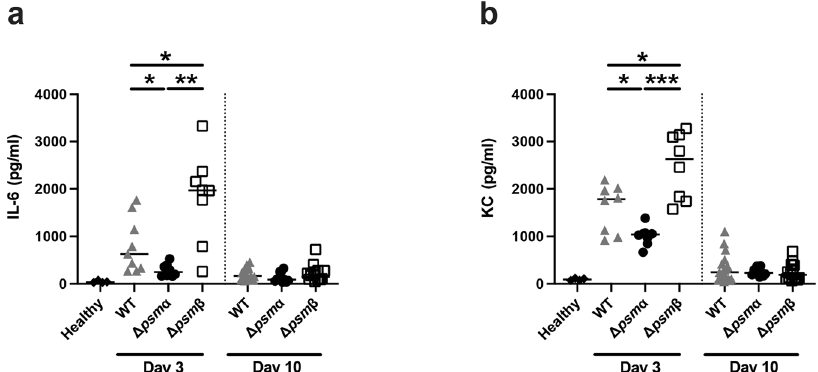
Fig. 7 PSM β de fi ciency upregulates serum cytokines in mice at the early phase. NMRI mice ( n = 8 – 21/group) were intravenously injected with S. aureus Newman (wild type, WT), or the isogenic mutant strains Δ psm α or Δ psm β mutants (5 × 10 6 CFU/mouse) and sacri fi ced on day 3 or day 10 post-infection. Serum levels of a interleukin 6 (IL-6) and b keratinocyte-derived chemokine (KC) were analyzed. The results from four independent experiments were pooled. The data are reported as mean ± standard error of the mean and analyzed with the Mann-Whitney U test. * P < 0.05; ** P < 0.01; *** P <